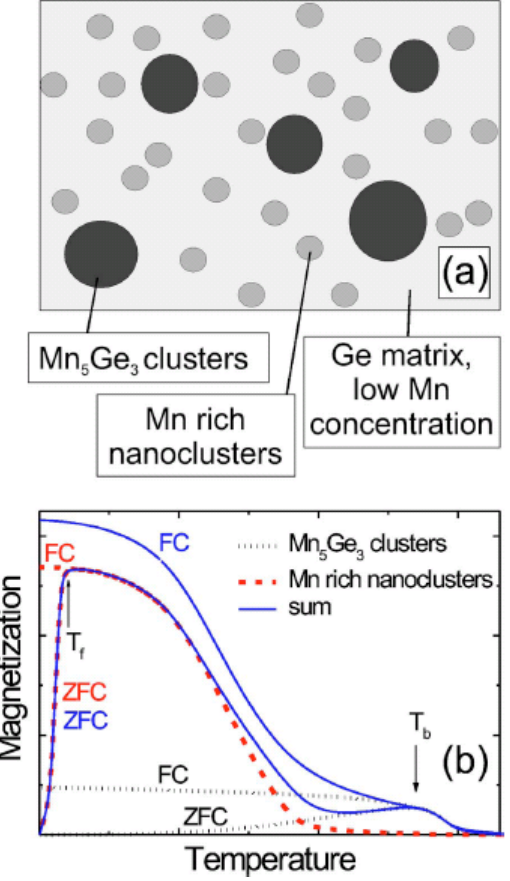
Figure 7 . (a) Illustration of the two different kinds of clusters present in Ge:Mn samples. (b) Schematic FC (field cooling) and ZFC (zero field cooling) magnetization curves for both kinds of clusters: black dotted curves for the contribution of the Mn curves for the Mn-rich nanoparticles and solid blue curves for the sum. (Reprinted with permission from Ref. [39]. Copyright 2006 by the American Physical